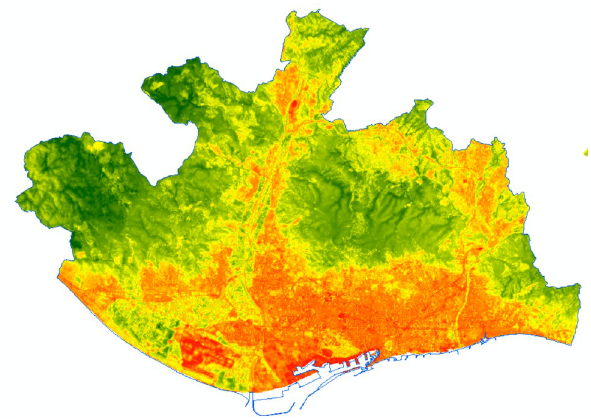
Figure 7. Nighttime LST (using summer NDVI) August 2015